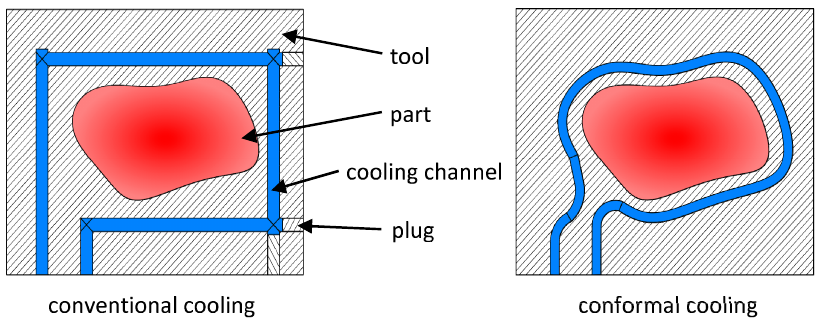
Figure 1. Schematic representation of a conventional cooling system ( left ) and a close-contour cooling system ( right ).